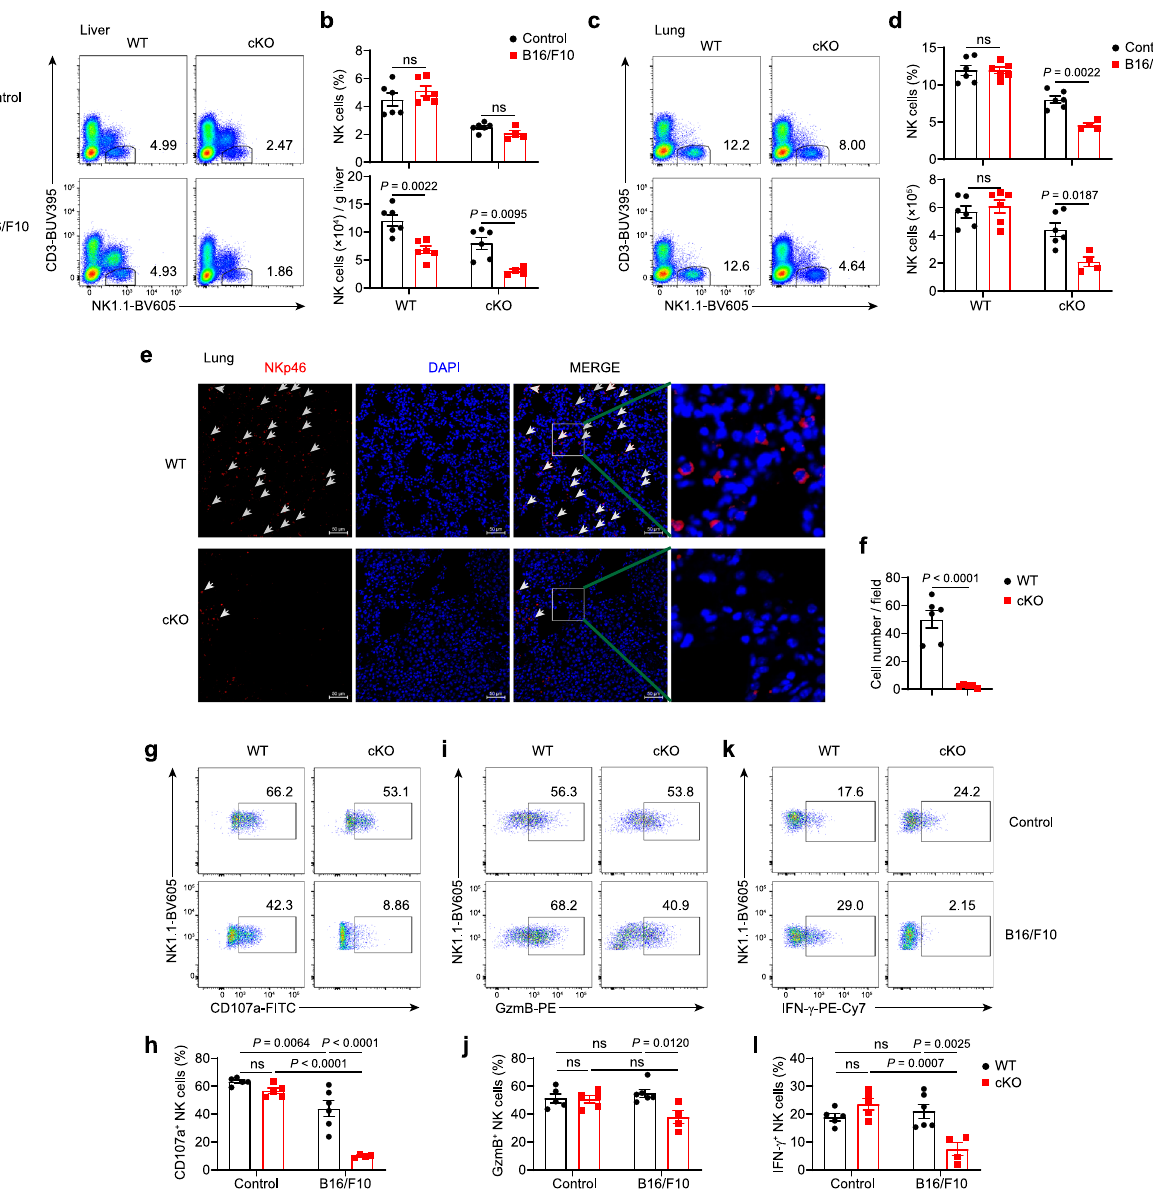
Fig. 4 METTL3 supports NK cells accumulation and effector function in the TME. a – d WT mice and cKO mice were harvested for fl ow-cytometric analyses 16 days after intravenous injection with 5 × 10 5 B16/F10 cells or PBS. a , c Representative plots showing expression of NK1.1 and CD3 in the liver ( a ) or lung ( c ) mononuclear cells from WT and cKO mice. b , d Percentages or absolute numbers of the liver ( b ) or lung ( d ) NK cells from WT mice ( n = 6/ group) and cKO mice ( n = 6 for the control group; n = 4 for B16/F10 group). e Immuno fl uorescence staining of lungs with anti-NKp46 (red) and DAPI (blue) from WT or cKO mice 25 days after intravenous injection with 2 × 10 5 B16/F10 cells. Scale bar, 50 μ m. The arrows indicate NK cells. f NKp46- positive cell numbers per fi eld based on ( e ) ( n = 6 for WT group; n = 5 for cKO group). g – l WT mice and cKO mice were harvested for fl ow-cytometric analyses 23 days after intravenous injection with 2 × 10 5 B16/F10 cells or PBS. Liver mononuclear cells were isolated and stimulated with PMA and ionomycin for 4 h for fl ow-cytometric analyses. Representative plots and percentages for the expression of CD107a ( g , h ), GzmB ( i , j ), and IFN- γ ( k , l ) expression among liver NK cells from WT ( n = 5 for the control group; n = 6 for B16/F10 group) and cKO mice ( n = 5 for the control group; n = 4 for B16/ F10 group). Each symbol represents an individual mouse ( b , d , h , j , l ) or individual fi eld of the microscope ( f ). Data are the mean ± SEM (ns, not signi fi cant; unpaired two-tailed t test ( f ) or one-way ANOVA ( b , d , h , j , l )). Source data are provided as a Source Data fi le. Data represent at least two independent experiments ( a – l